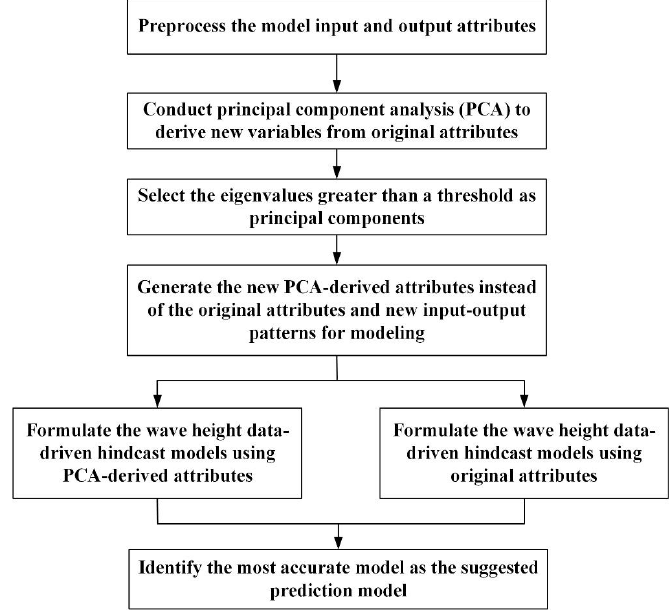
Figure 2. Flowchart of the proposed principal component analysis (PCA)-based data-driven wave height prediction models.